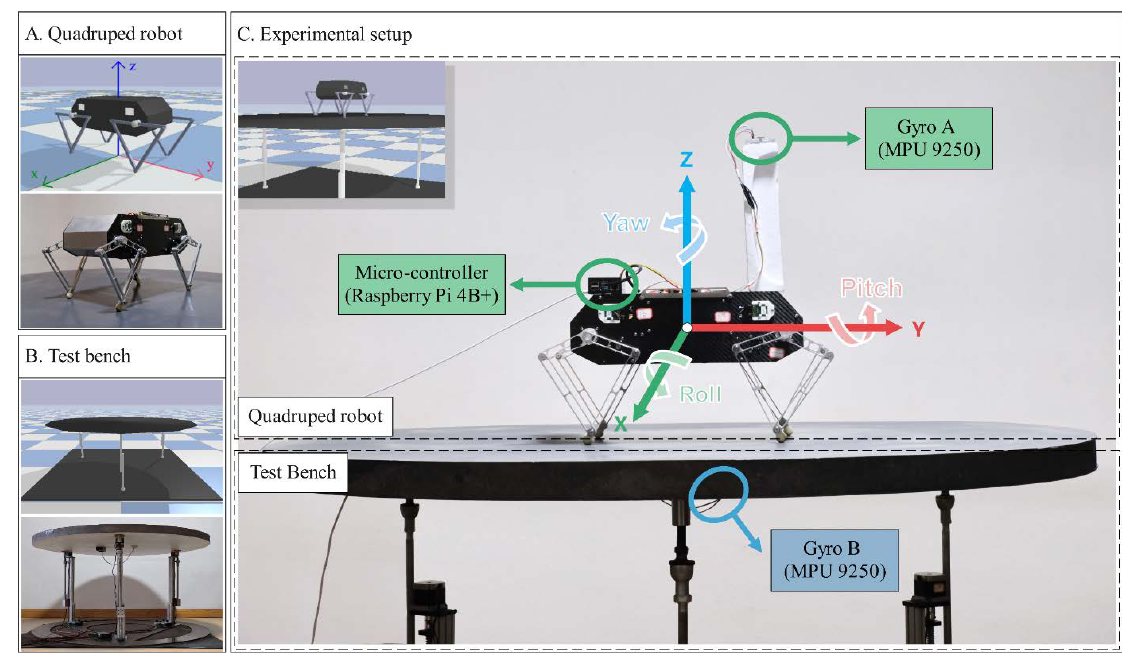
Figure 3. Experimental setup in simulation and real world.